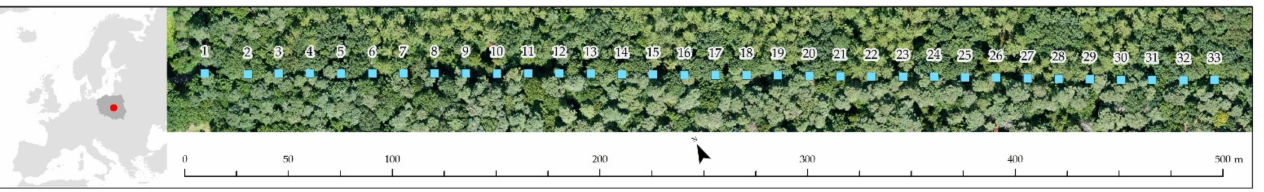
Figure 1. The location of control points on the background of UAV